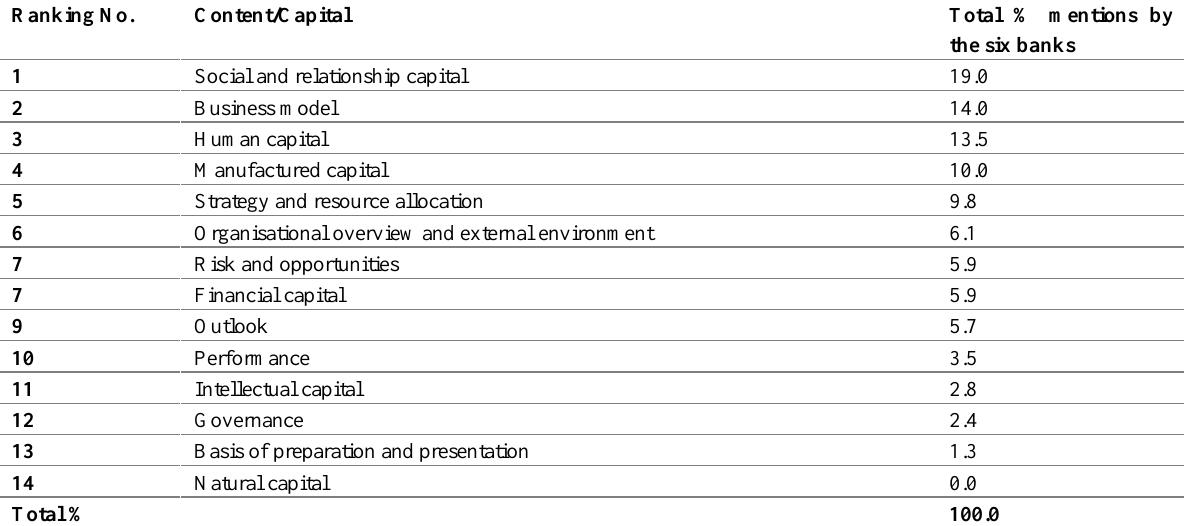
Table 3: Ranking of the reported content/capital